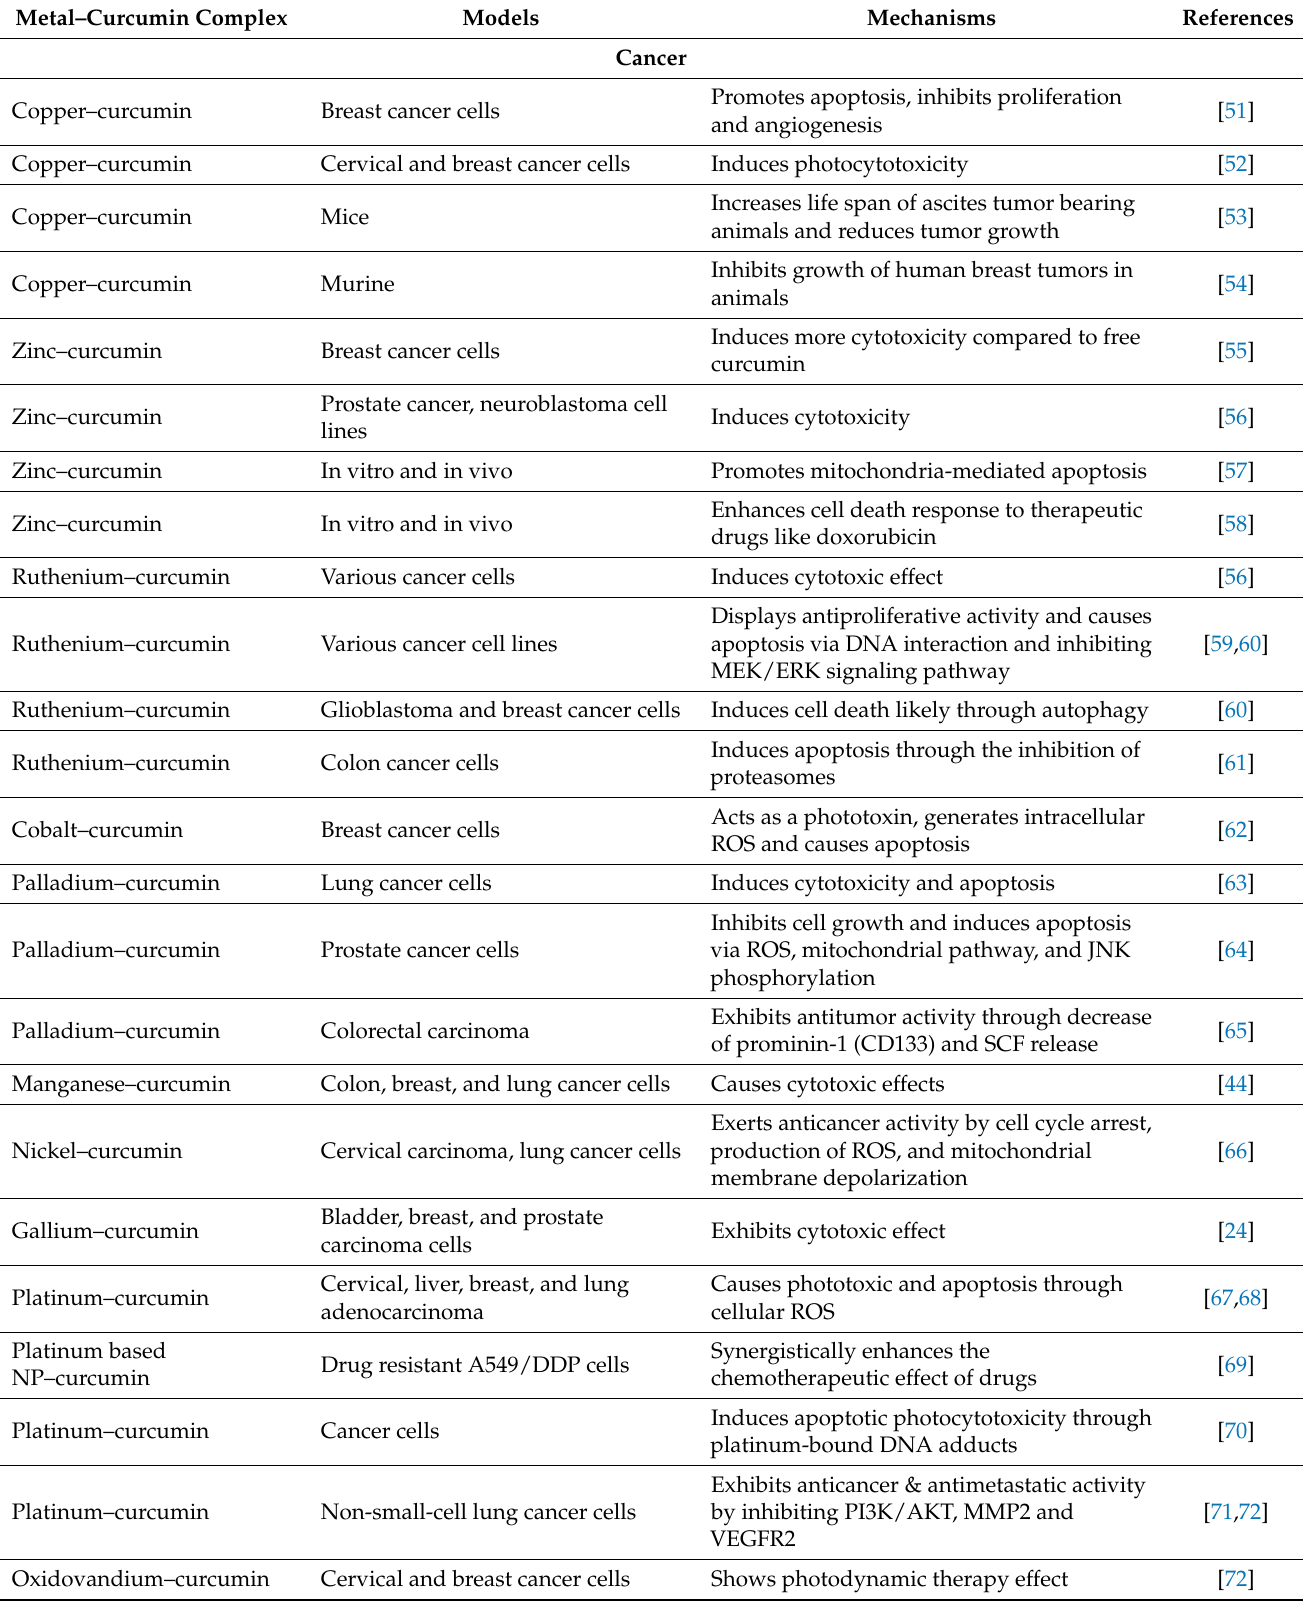
Table 2. Prevention and treatment of chronic inflammatory diseases by metal–curcumin